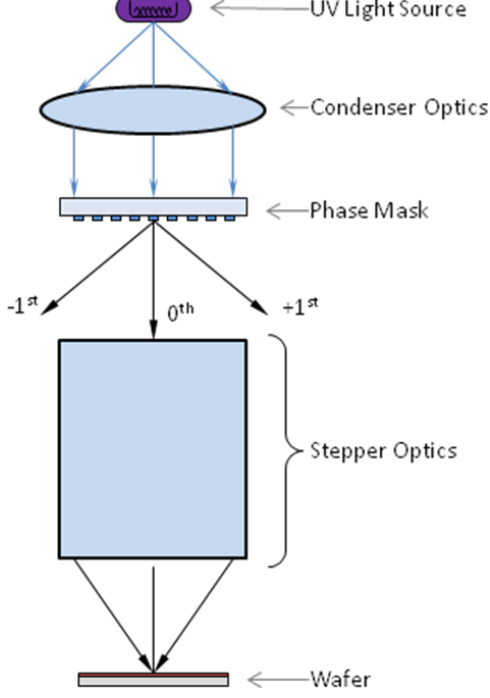
Figure 9. Schematic drawing of analog